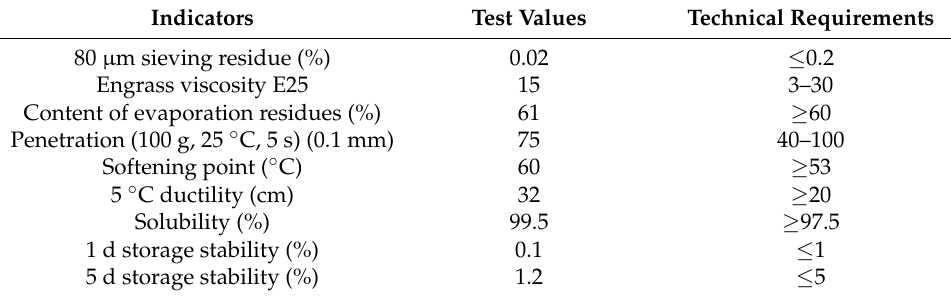
Table 3. Basic technical indexes of SBS-modified emulsified asphalt.